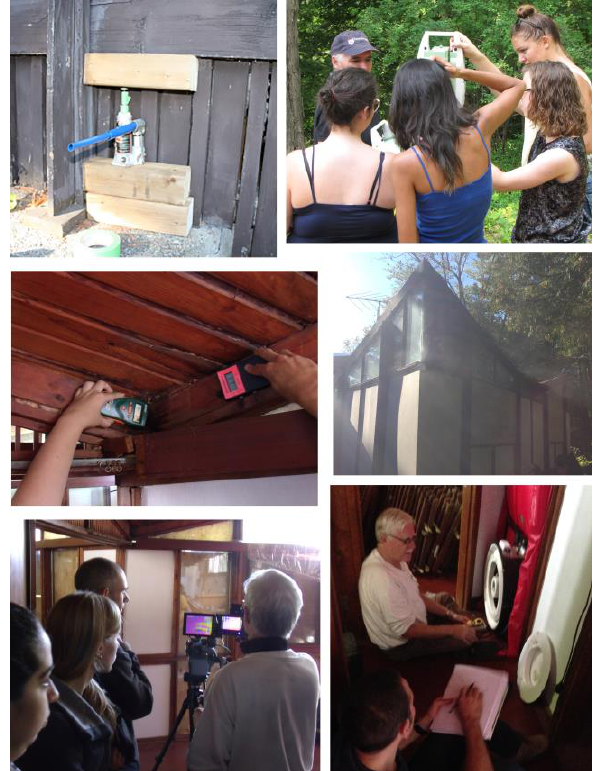
Figure 12. FSF Workshops: Platform Levelling, 3-D Scanning, Moisture and Metal Detection, Smoke Testing, Thermography and Blower door (left to right top